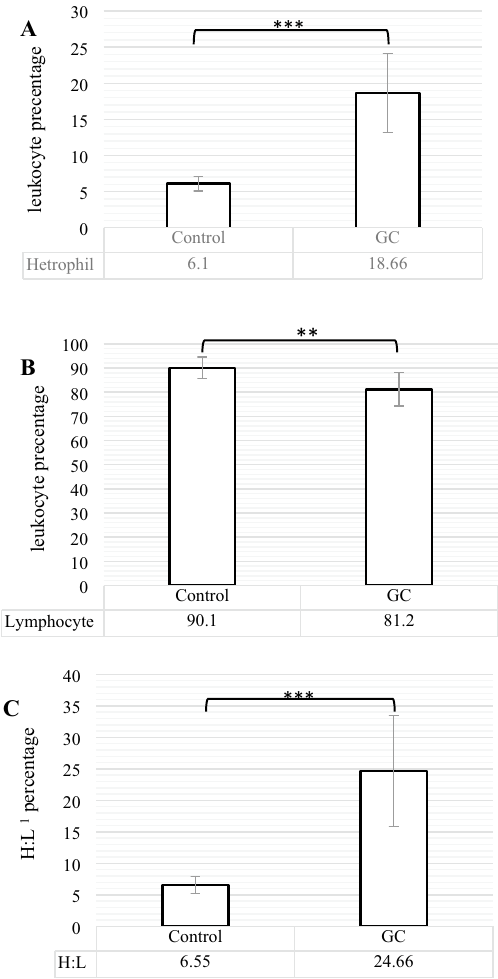
Figure 3. The comparison of heterophil (neutrophil) ( A ), Lymphocyte ( B ), and heterophile: lymphocyte ratio ( C ) between control and GC (Glucocorticoid Fluticasone, 2 ppm). Different statistical marks are significant (*P ≤ 0.05, **P ≤ 0.01, and ***P ≤ 0.001) according to the Dunnett’s test as a comparison procedure. (1) Heterophil: lymphocyte ratio.